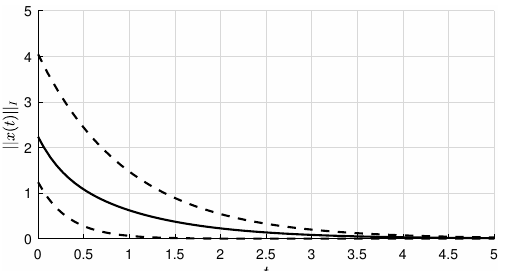
Figure 4. Solution of the linear time-varying system from Example 3 with initial state x ( 0 ) = ( 2, − 1 ) T (the solid line) and the lower and upper bounds given by (3), (9) and (10) (the dashed